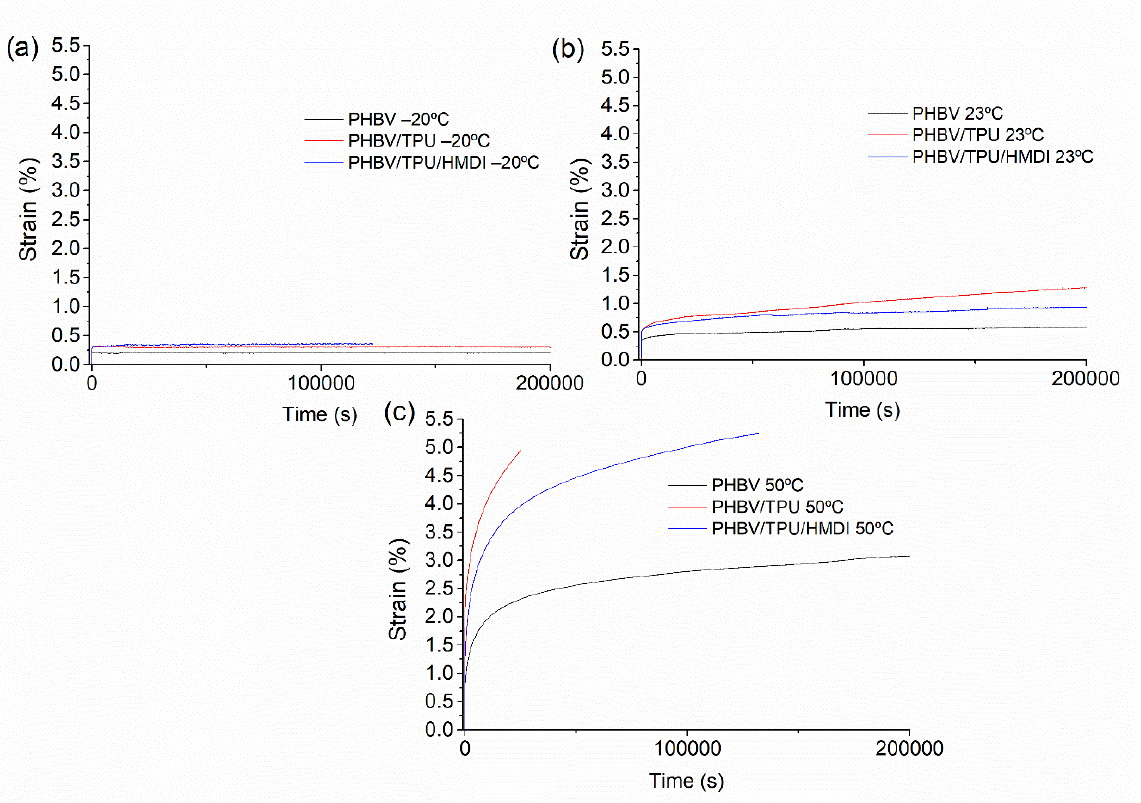
Figure 10. The tensile creep curves at 15 MPa of the neat PHBV and PHBV/TPU blends at ( a ) − 20 °C, ( b ) 23 °C, and ( c ) 50 °C.